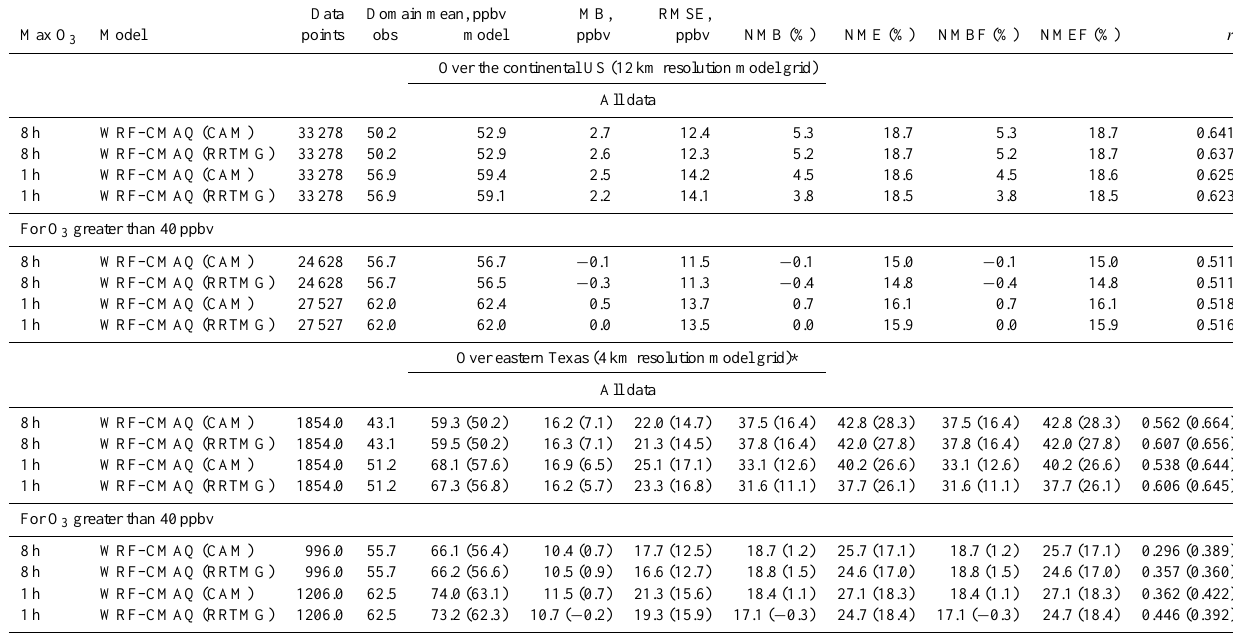
Table 4. Comparison of the WRF–CMAQ/CAM and WRF–CMAQ/RRTMG models for operational evaluation of maximum 1h and 8h O 3 concentrations on the basis of the AQS data over the continental United States (12km resolution model grid) and eastern Texas (4km resolution model grid) for August of 2006. “Domain mean” means the results on the basis of all data at observational sites within the